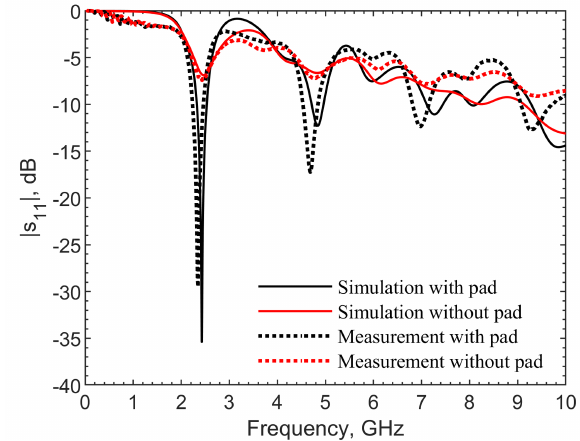
Figure 16. Comparison of measurements and simulations for tuned- and untuned-loop resonators with U = 9. Both have a SMA adaptor between the device and coaxial cable. The simulations are conducted with a 3-D SMA adaptor model included. The calibration is conducted at the coaxial output of the SMA adaptor. The tuned loop resonator has d = 1.9